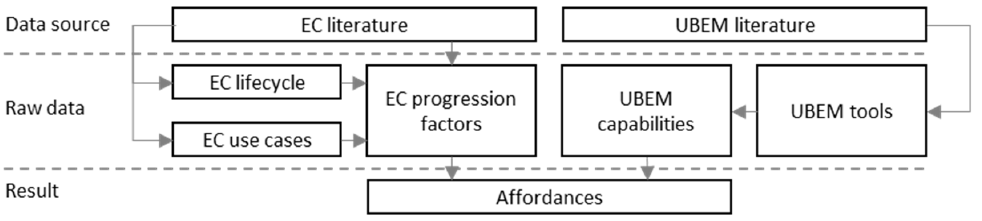
Figure 3. Overview of research process.